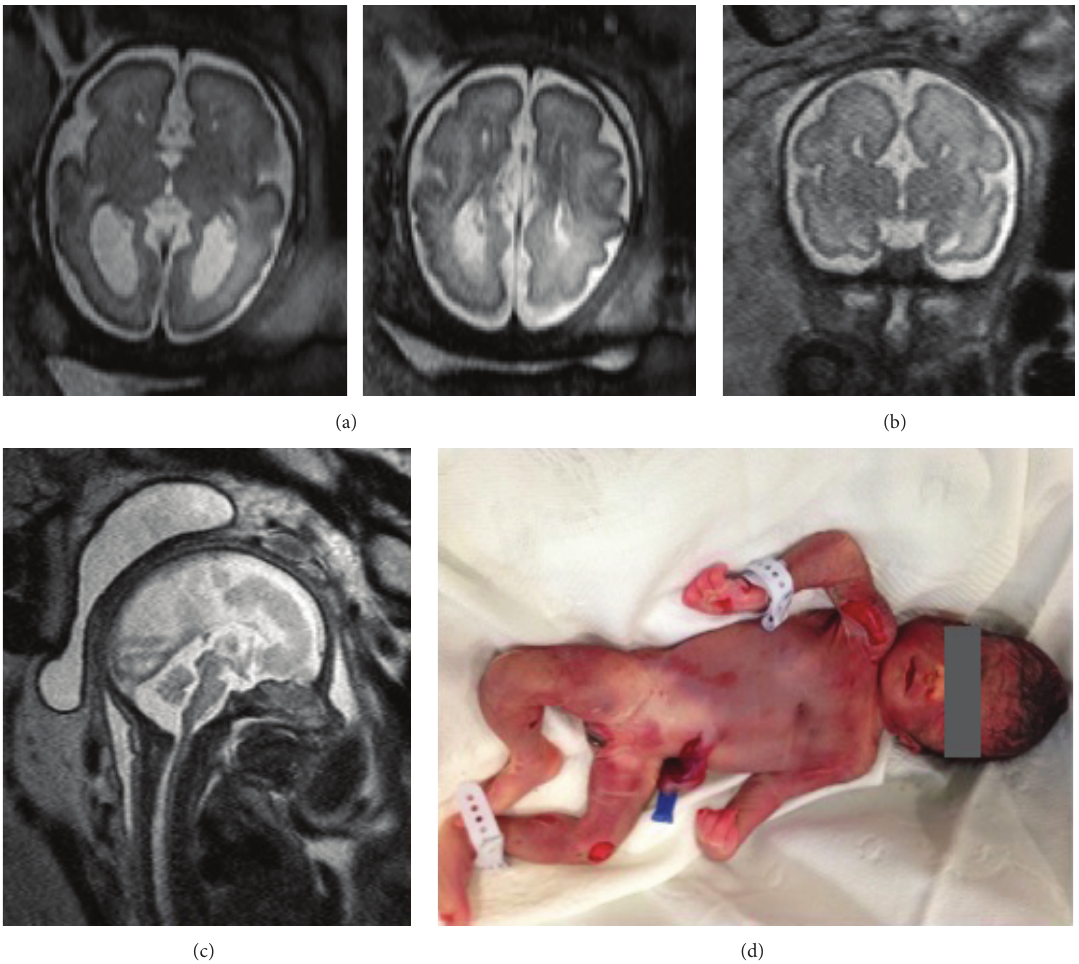
Figure 2: Fetal MRI images of absent corpus callosum and the picture of the newborn. (a) Axial scans at the level of the atria and bodies of the lateral ventricles show bilateral posterior ventriculomegaly. Anteriorly the lateral ventricles are narrow and parallel. This is the appearance of colpocephaly which is characteristically associated with ACC. (b) Coronal MRI scan at the level of third ventricle shows agenesis of the corpus callosum. The bodies of the lateral ventricles have a lateral convexity in the coronal plane and a medial concavity due to the presence of Probst’s white matter bundles. This is the typical appearance in callosal agenesis. (c) Midsagittal MRI scan confirms absence of the corpus callosum. (d) Photograph taken in the postnatal